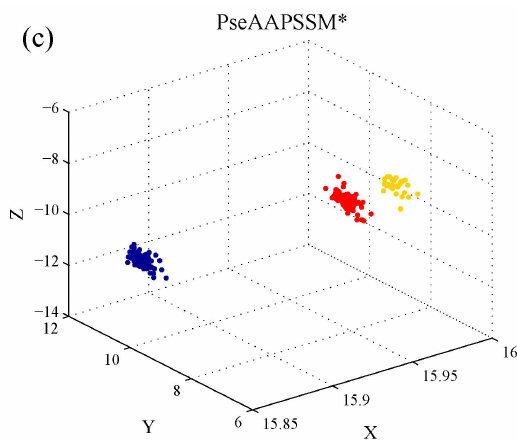
Figure 5. 3D scatter on Dataset 2 with X-, Y- and Z-axes representing the first three components of LDA, respectively: ( a ) DipPSSM; ( b ) PseAAPSSM and ( c ) the patch of high resolution for the indicated region in ( b ).